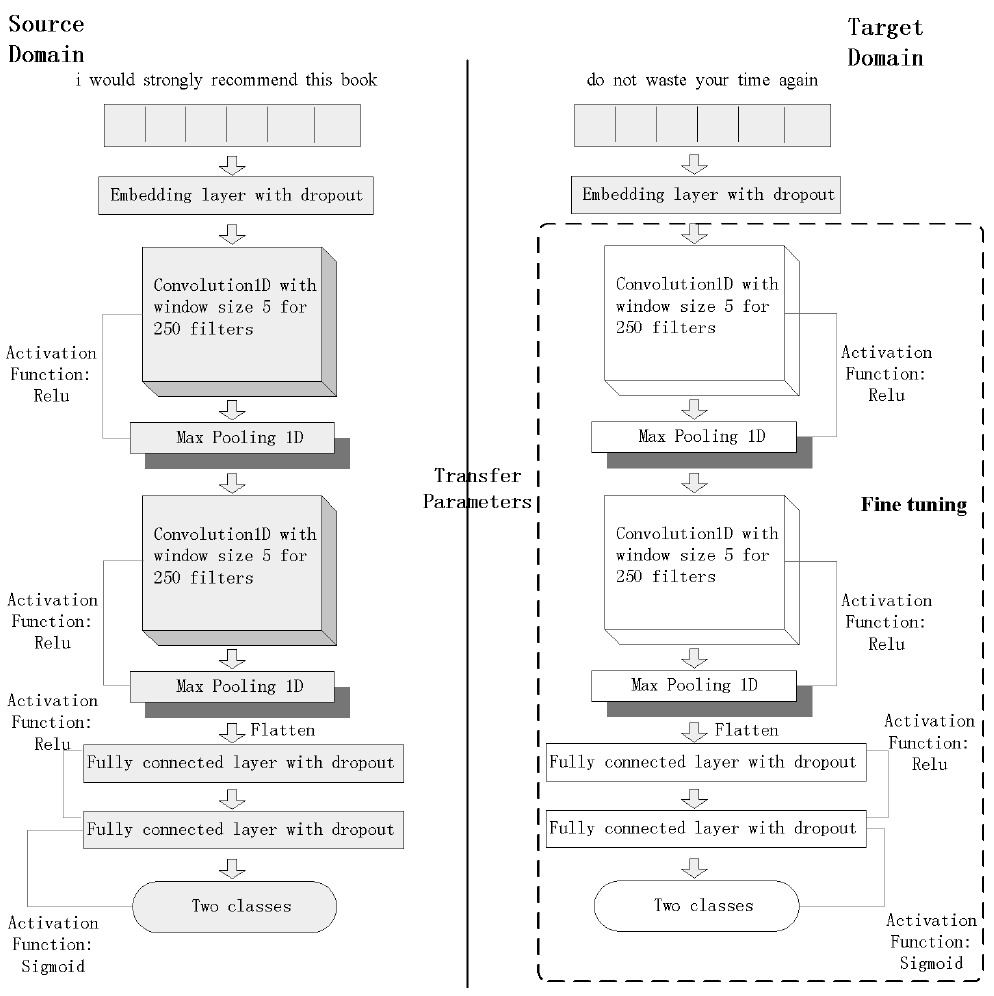
Figure 1. Architecture of LM-CNN-LB for cross-domain product review sentiment